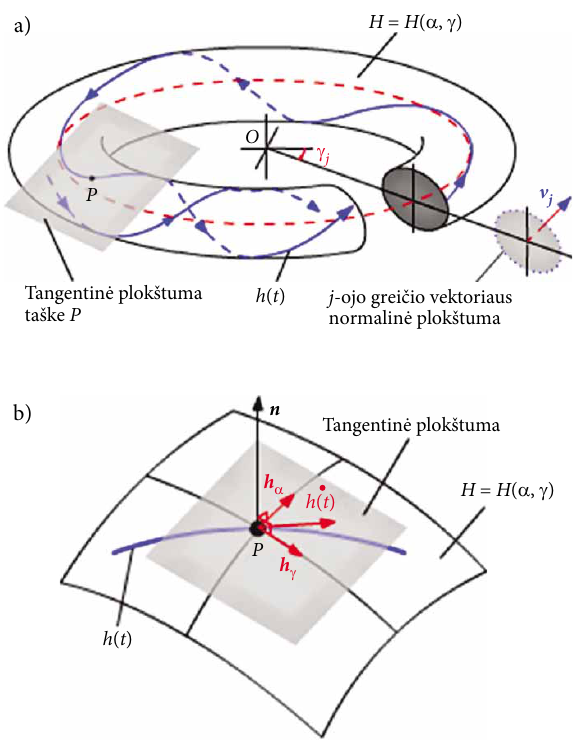
paviršiuje H = H ( (cid:68) , (cid:74) ) (energijos toras): a – tangentinė plokštuma toro paviršiaus taške P ; b – fazinės trajektorijos h ( t ) tangentinis vektorius (cid:11) (cid:12) (cid:5) h t ir normalinis vektorius Fig. 20. Phase trajectory h ( t ) = h ( (cid:68) ( t ), (cid:74) ( t )) on parametric surface H = H ( (cid:68) , (cid:74) ) (energy torus): a – tangent plane at torus surface point P ; b – tangent vector (cid:11) (cid:12) (cid:5) h t and normal vector n of phase trajectory h ( t ) at point P